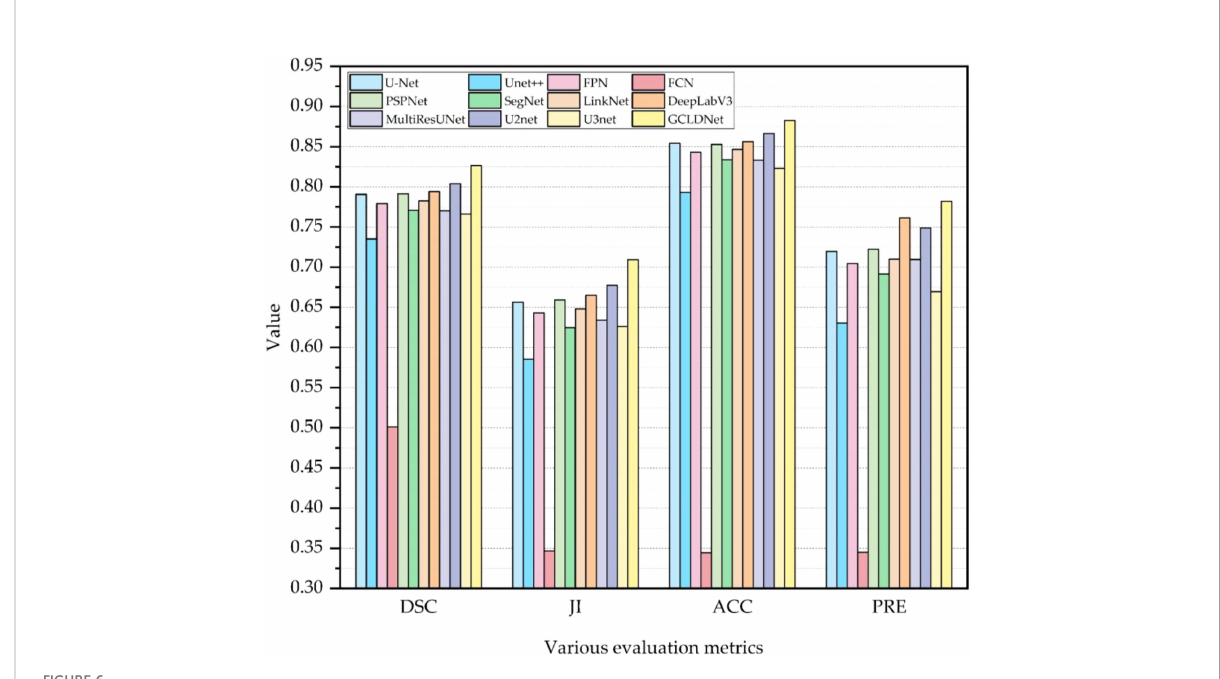
FIGURE 6 Visual comparison of the performance of different models on the SEED